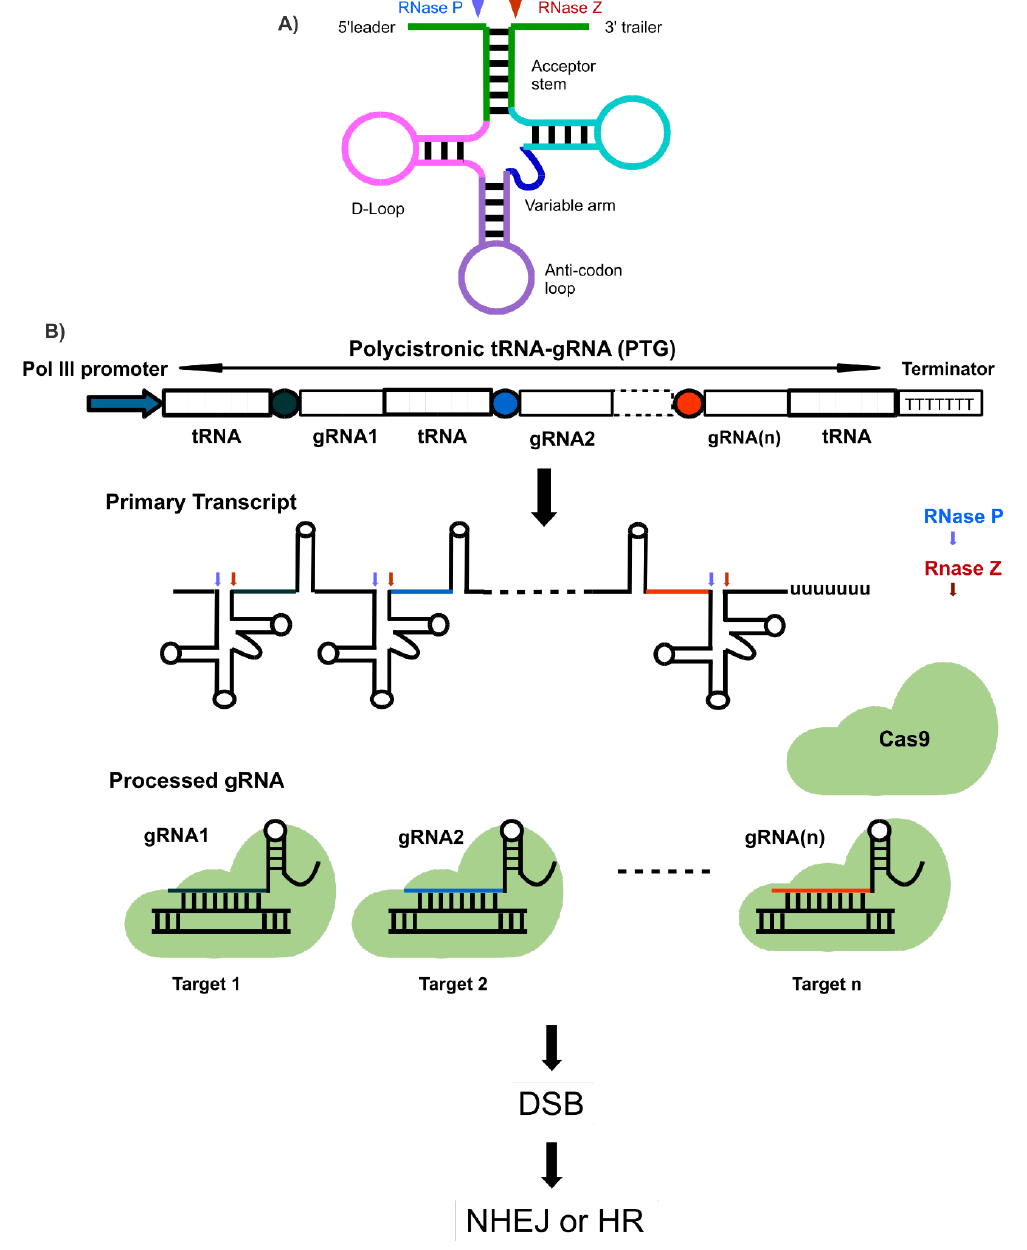
Figure 3. Multigene targeting via CRISPR / Cas9 using PTG / Cas9 method. ( A ) A eukaryotic pre-tRNA with a depiction of post-transcriptional processing by RNaseP and RNaseZ (depicted as blue and red arrows respectively), splicing out 5 (cid:48) leader and 3 (cid:48) trailer respectively. ( B ) Here, each gRNA with target-specific sequence (labelled here as circles of di ff erent colors) and conserved gRNA sequence (blank rectangle) is fused to a tRNA coding sequence (rectangles with boxes), which is cleaved after transcription by RNaseP and RNaseZ to release mature tRNAs and gRNAs (with lines of same colors as the circles). These processed gRNAs direct Cas9 to the target site, which then causes a double-strand break (DSB), which is repaired by NHEJ or Homologous recombination